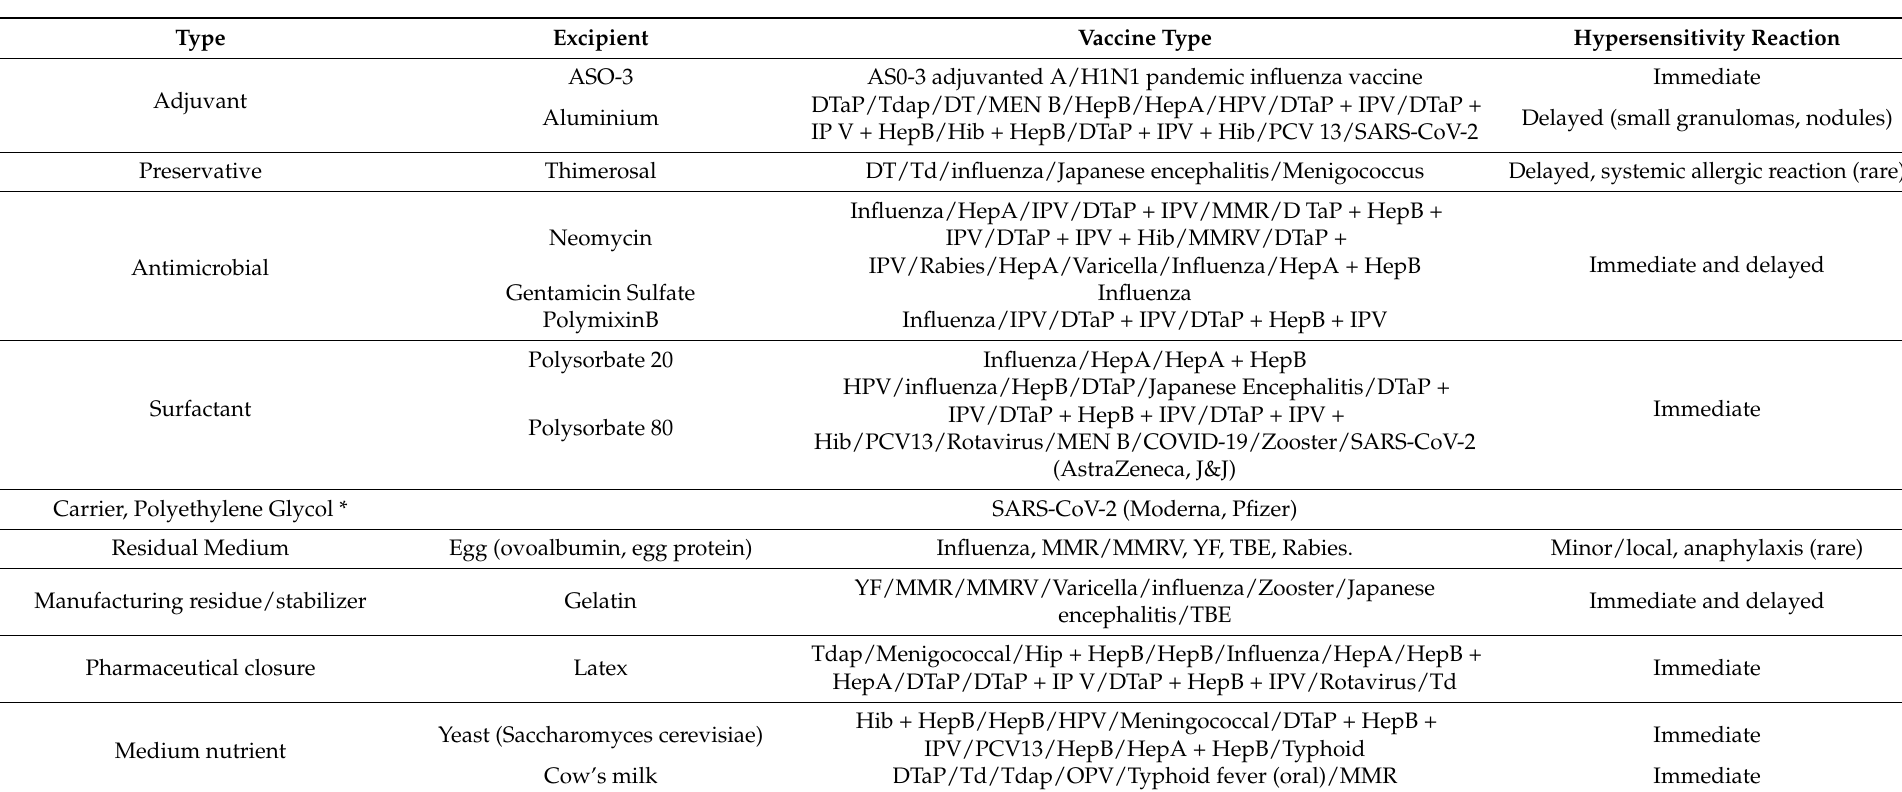
Table 1. Type of potential triggers of hypersensitivity reactions that are contained in vaccines to infectious diseases [20,21]. * PEG in this formulation is a carrier and not an excipient. It is conjugated to one of four lipids that make up the PEGylated lipid nanoparticles. Vaccines based on mRNA use lipid nanoparticles to facilitate the transport of mRNA into